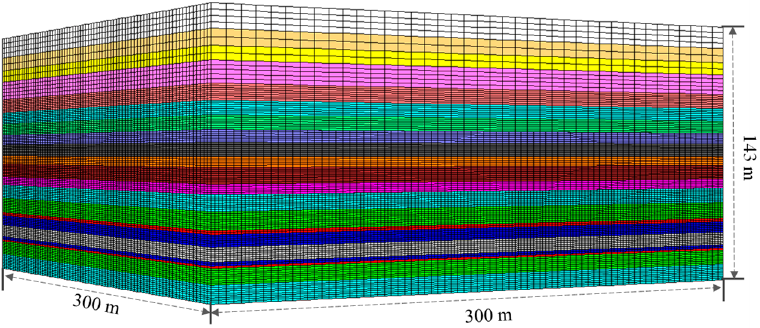
Figure 3. The numerical model in FLAC 3D. Table 1. The mechanic parameters of coal-rock